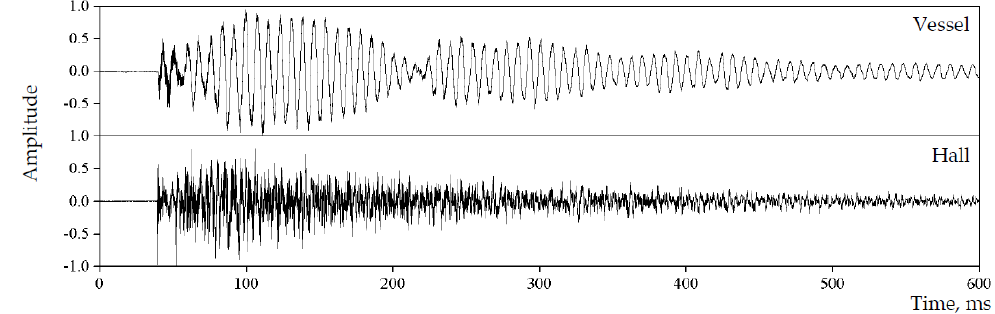
Figure 9. Impulse responses measured inside the vessel and at the seat nearest to the vessel.